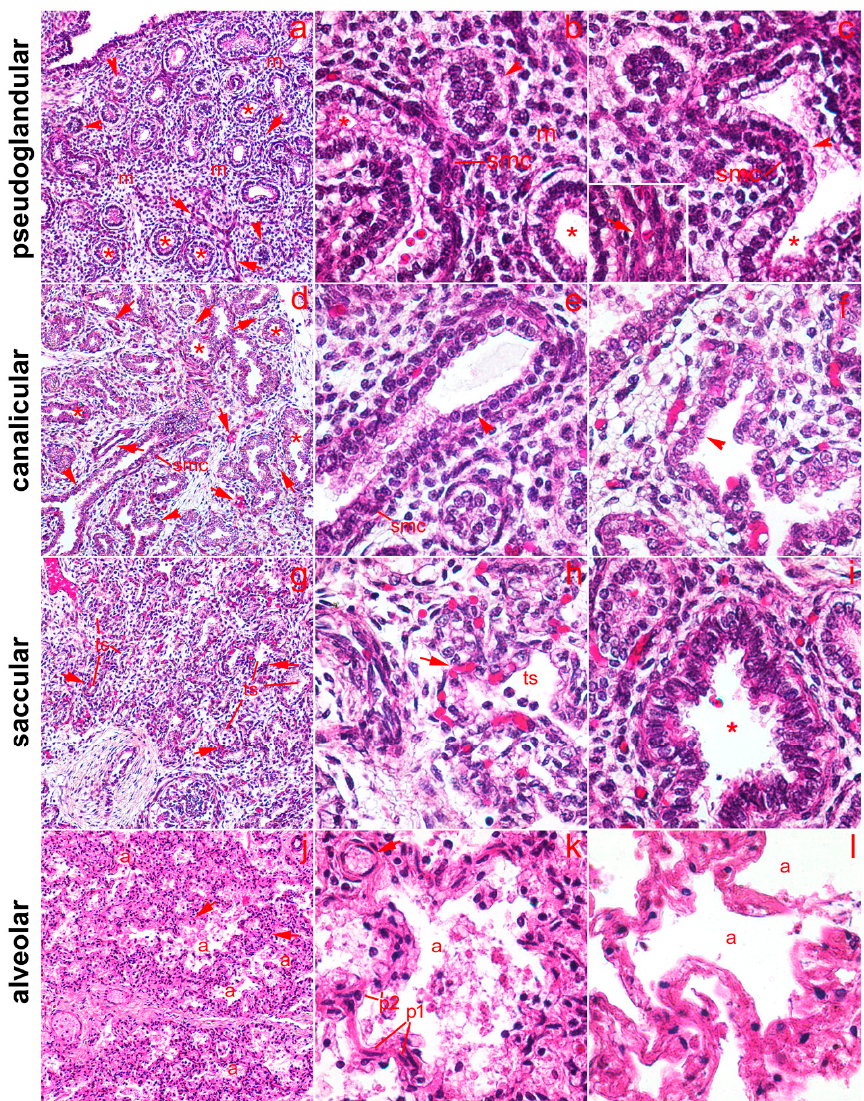
Figure 1. Fetal lungs at various stages of development. ( a – c ) Pseudoglandular stage. ( a ) 100 × magnification shows typical appearance of lung in pseudoglandular stage with small lumina of proximal airways (asterisks) and abundant mesenchyme (m) with some blood capillaries (arrows). Lumina of some proximal airways are not yet open (arrowheads). ( b , c ) Details of lung histology in the pseudoglandular phase (400 × magnification): proximal airways with columnar epithelium (asterisks); transition from proximal to distal airways (arrowheads), shown in ( c ), where the transition from columnar to cuboidal epithelium is clearly visible; m—mesenchyme; smc—smooth muscle cells visible beneath the proximal airway epithelium. Inset in ( c )—detail of capillary (arrow) with red blood cells. ( d – f ) Canalicular stage. Larger lumina of proximal airway and increased vascularity can be seen. ( d ) 100 × magnification; ( e , f ) 400 × magnification. ( f ) The epithelium lining the distal airways is cuboidal (arrowhead). ( g – i ) Saccular stage (terminal sac), showing the development of terminal sacs (ts) with differentiation of type I and II pneumocytes from the cuboidal epithelium and the invasion of capillaries (arrows) are clearly visible. ( g ) 100× magnification; ( h , i ) 400× magnification. ( h ) Detail of end sac showing differentiation of type I and II pneumocytes from cuboidal epithelium; ( i ) detail of proximal airway showing columnar epithelium. ( j , k , l ) Alveolar stage, showing development of characteristic alveoli, shown in ( a ), with thin septal walls and differentiation of type I (p1) and II pneumocytes (p2). ( j ) 100× magnification; ( k , l ) 400× magnification. ( l ) Details of developed alveoli ( a ).